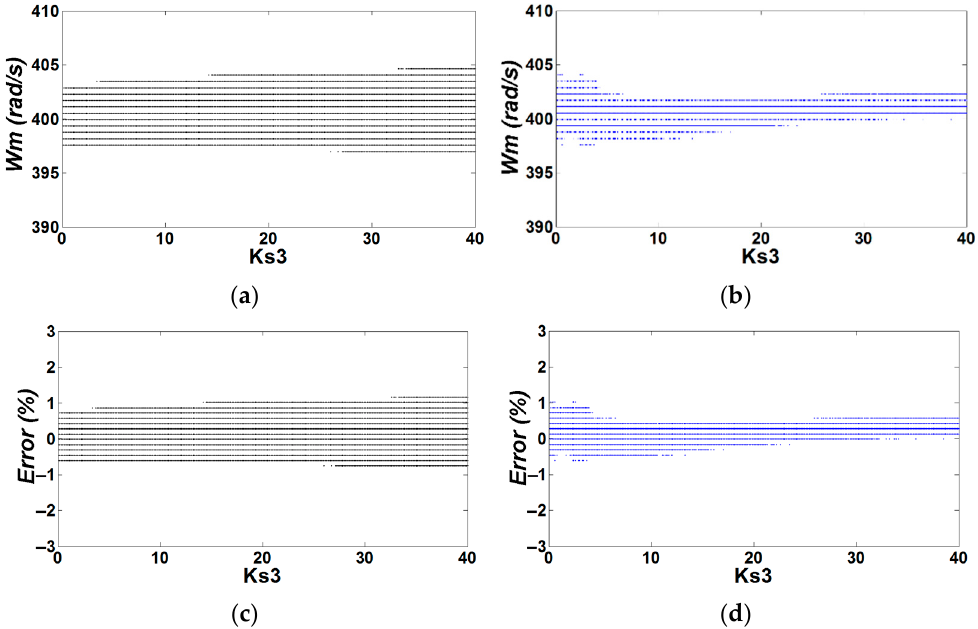
Figure 8. Bifurcation diagrams of the buck-motor system controlled with ZAD ( K S 1 = K S 2 = 2 K S 3 = 40, delay time 166.6 µ s, and quantization effects): ( a ) W m vs. K S 3 numerical, ( b ) W m vs. K S 3 experimental, ( c ) error vs. K S 3 numeric, and ( d ) error vs. K S 3 experimental.